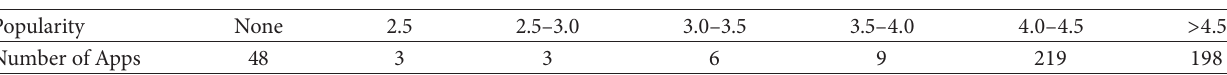
Table 5: Initial distribution of malware Apps by popularity in July 2011 in the nonofficial market. Repackaging is also considered.